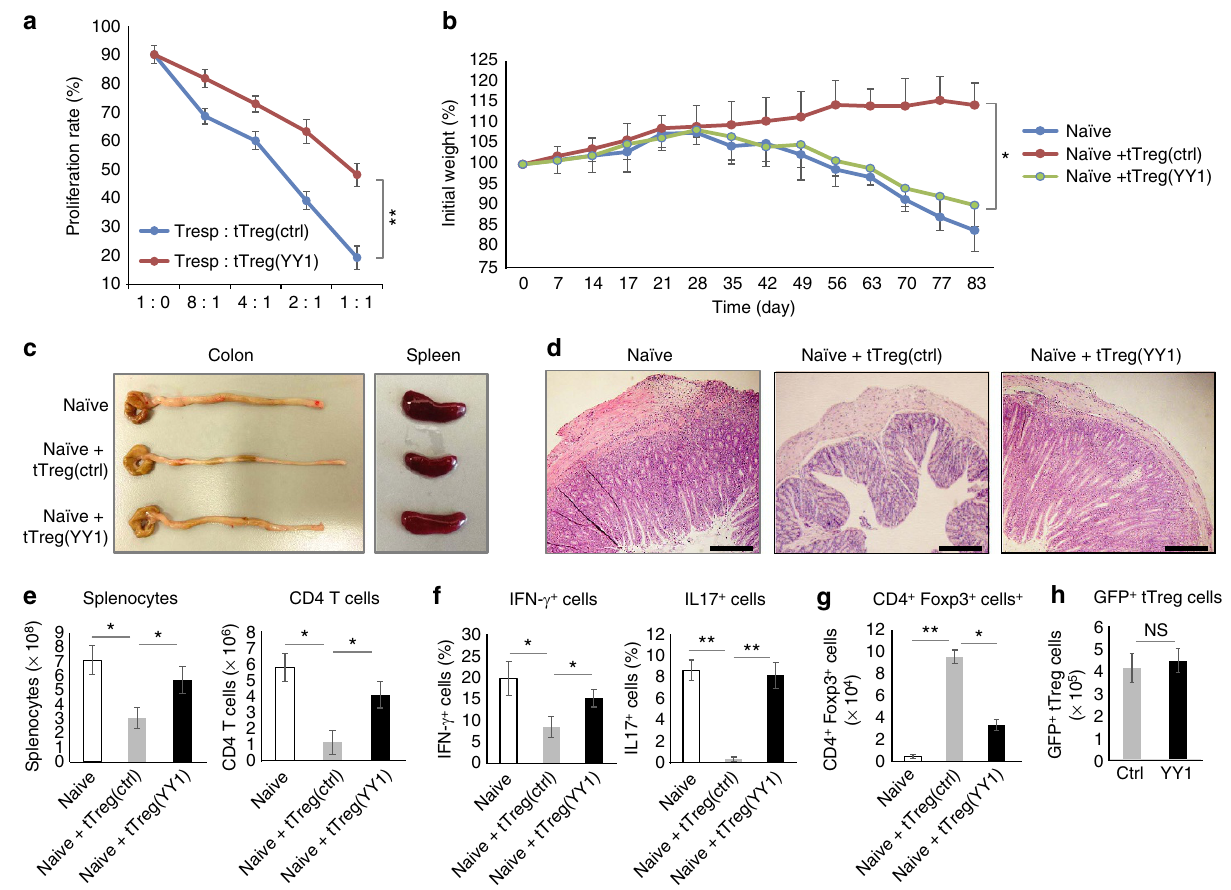
Figure 4 | YY1 impairs immunosuppressive function of tT reg cells in vitro and in vivo . ( a ) In vitro immunosuppressive activity of tTreg cells was assessed by proliferation of CD4 þ CD25 (cid:2) Tresp cells (labelled with CFSE from CD45.1 þ T resp cells). Foxp3 þ Treg cells were isolated from Foxp3-RFP knock-in mice and transduced with control or YY1-expression vector. GFP þ control tTreg (tTreg(ctrl)) or GFP þ YY1-overexpressing tTreg (tTreg(YY1)) cells were sorted, mixed with CD4 Tresp cells in various ratios, and cultured in the presence of anti-CD3/CD28 beads for 3 days. Proliferation was measured on CD45.1 þ (T resp ) cells. ( b – h ) In vivo immunosuppressive activity of tTreg cells was assessed by inflammatory bowel disease model. tT reg (ctrl) and tT reg (YY1) cells were prepared as in a from Foxp3-RFP knock-in mice. Naı¨ve CD4 T (CD4 þ CD25 (cid:2) CD62L þ CD45RB high ) cells alone or together with tT reg (ctrl) or tT reg (YY1) cells were adoptively transferred into RAG1 (cid:2) / (cid:2) mice. The mice were killed at 12 weeks after the cell transfer, and analysed for disease phenotypes. ( b ) Body weight of the recipient mice was presented as a percentage of the initial weight. ( c ) Gross morphology of colons and spleens. ( d ) Haematoxylin and eosin staining of colon sections. Scale bar indicates 200 m m. ( e ) Absolute numbers of splenocytes and splenic CD4 T cells. ( f ) Frequency of cytokine-producing effector CD4 T cells in the spleen. ( g ) Absolute numbers of CD4 þ Foxp3 þ cells from the spleen. ( h ) Absolute numbers of GFP þ tTreg cells from the spleen. Error bars shown in b – h represent s.d. Statistical differences in b – h were analysed by Student’s t -test ( n ¼ 5). * P o 0.05. ** P o 0.01. NS, not